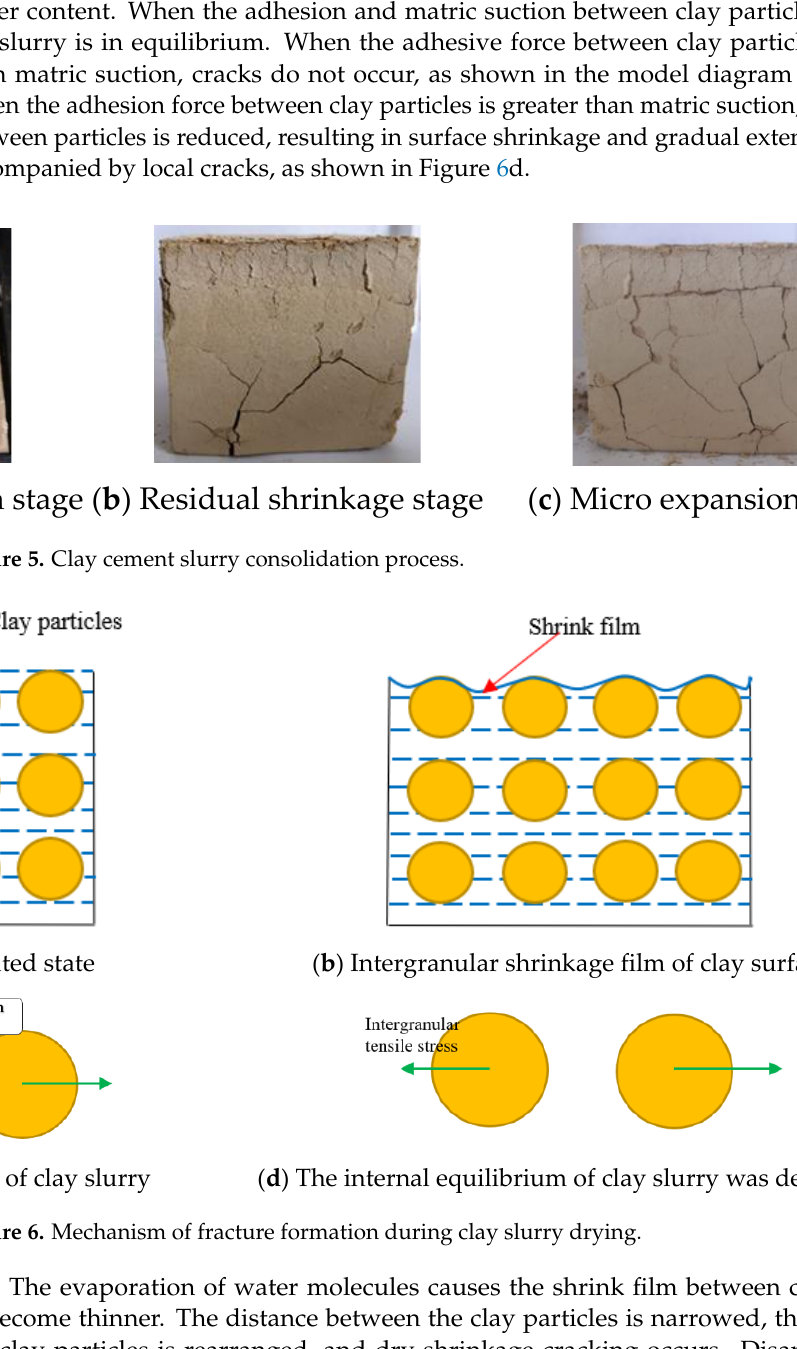
Figure 6. Mechanism of fracture formation during clay slurry drying.